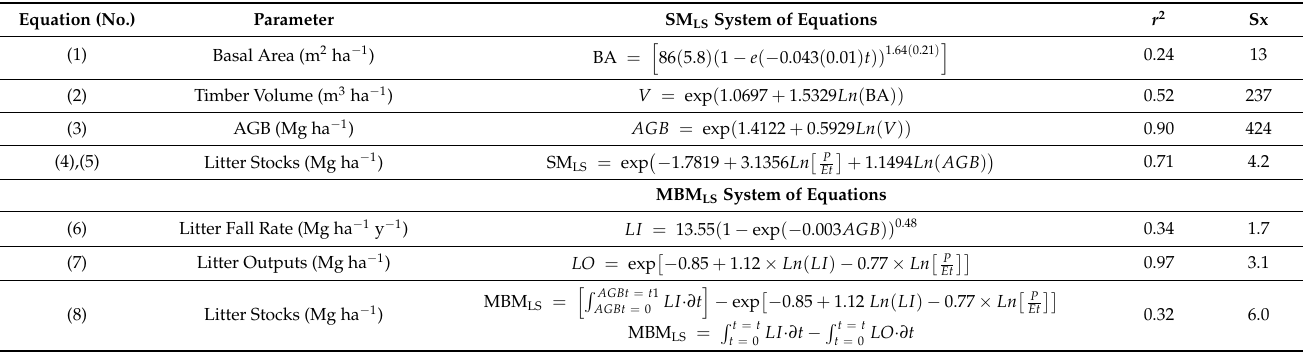
Table 2. Plot-level parameters and the volume growth and yield model developed to litter stocks and accumulation rates of Northern Mexico non-industrial forest